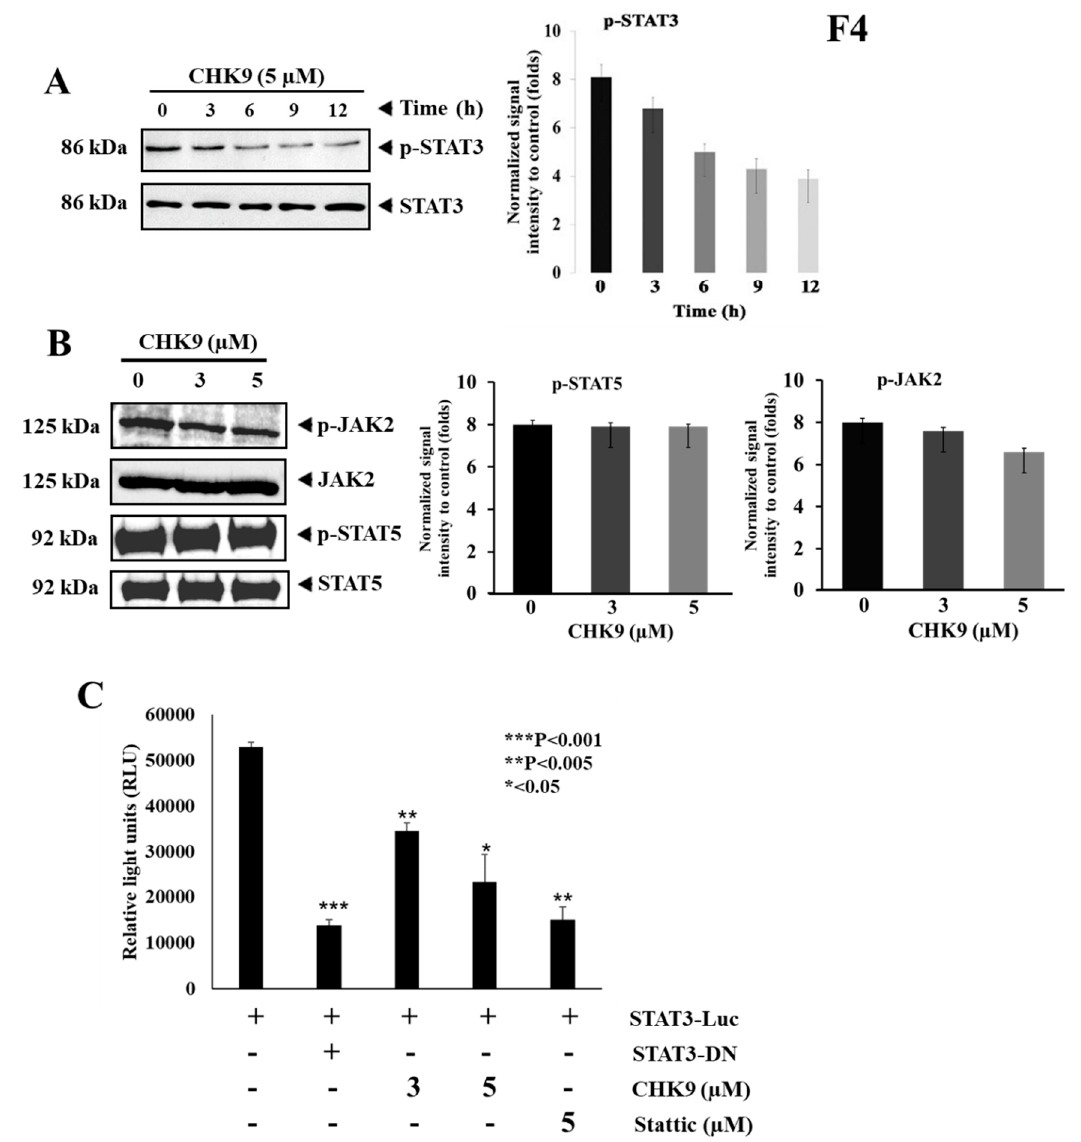
Figure 4. CHK9 suppresses the phosphorylation of STAT3 Y705 without affecting JAK2. ( A ) A549 cells were treated with CHK9 (5 µM) for indicated time-points and the whole-cell lysate was prepared to use it for Western blotting to analyze the expression of phospho-STAT3, STAT3 and its graphical representation of the relative normalized intensity with respective loading controls. ( B ) A549 cells were treated with the indicated concentrations of CHK9 (3 and 5 µM) for 24 h and the whole-cell lysate was prepared to use it for Western blotting to analyze the expression of phospho-JAK2, JAK2, phospho-STAT5, and STAT5. ( C ) A549 cells were transfected with STAT3-responsive elements conjugated reporter gene and these cells were incubated with indicated concentrations of CHK9 for 24 h and examined for luciferase activity. All luciferase experiments were done in triplicate and repeated twice.